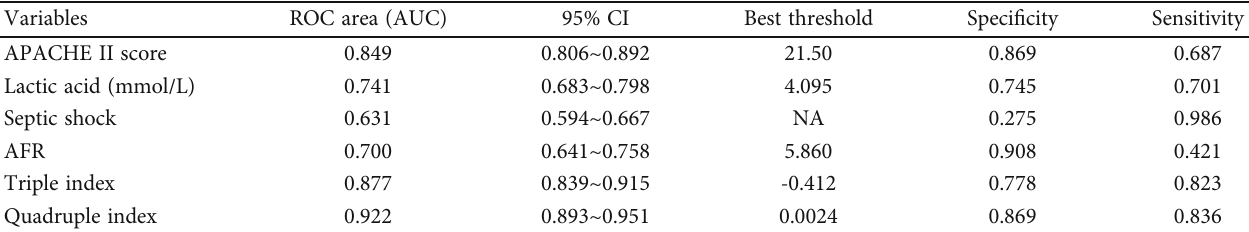
Table 4: Predictive valve of APACHE II score, lactic acid, septic shock, AFR, triple index, and quadruple index for 28-day mortality in patients with sepsis.